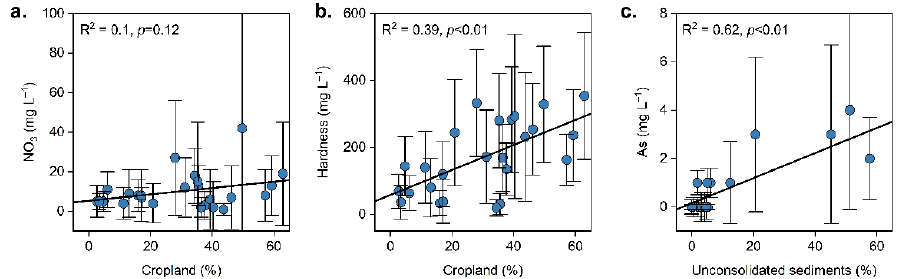
Figure 5. The relationships between NO 3– concentration ( a ) and hardness ( b ) and cropland, and between As concentration and unconsolidated sediments ( c ).